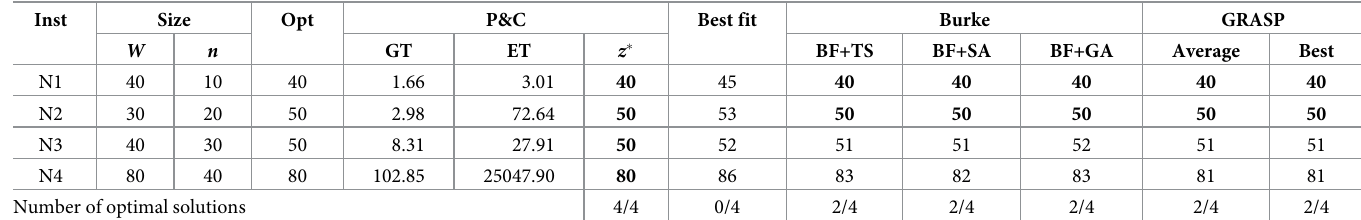
Table 6. Results for burke instances.